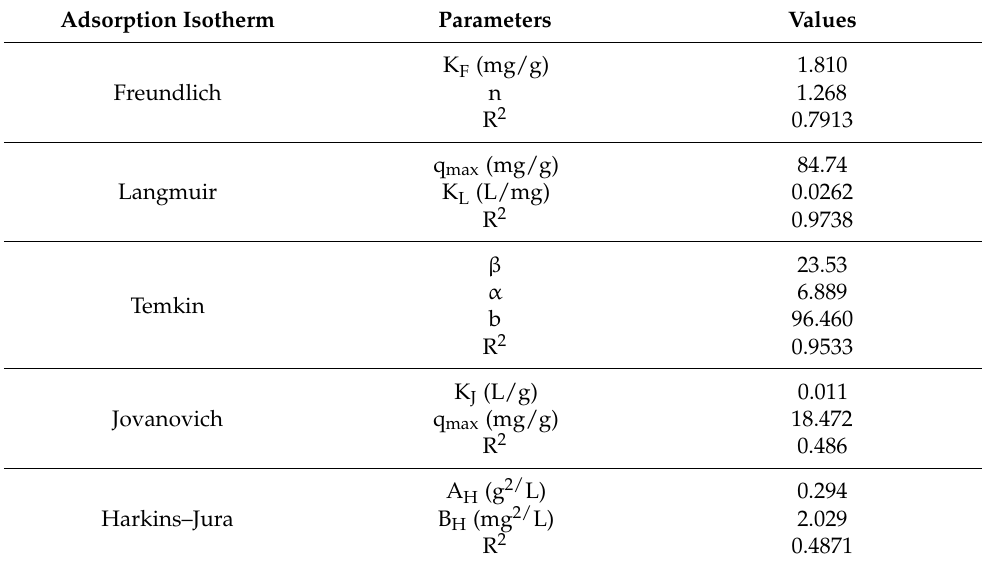
Table 2. Isothermal parameters for adsorption of Zn (II) on CMPVL.